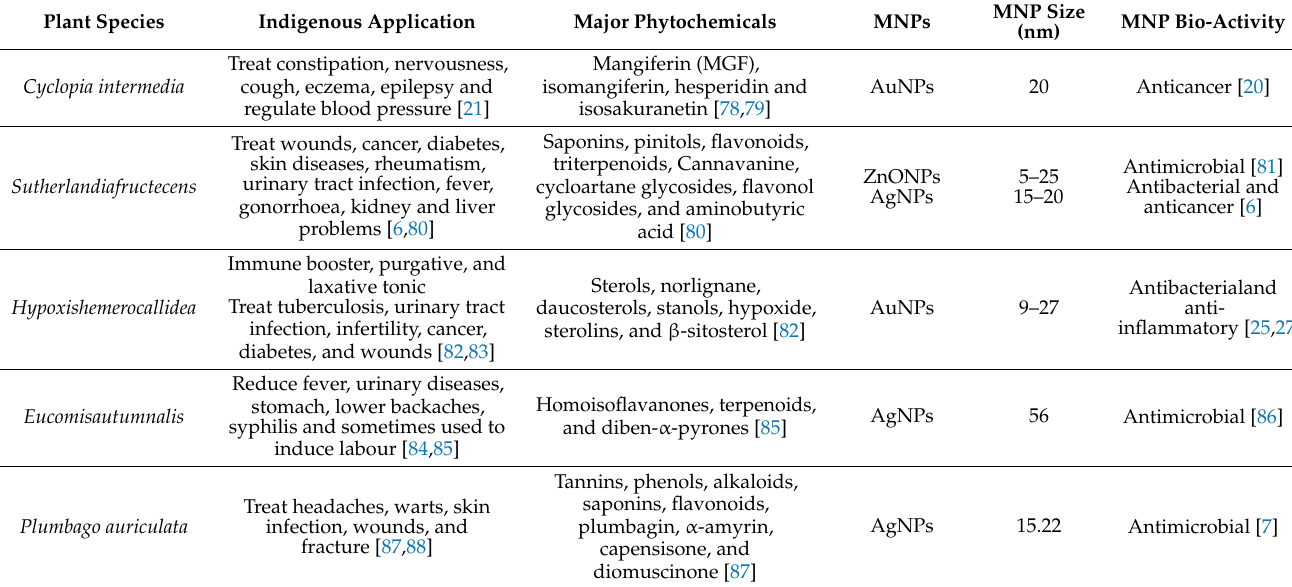
Table 1. List of selected South African medicinal plants utilized for MNP synthesis and their biological activity. Plant